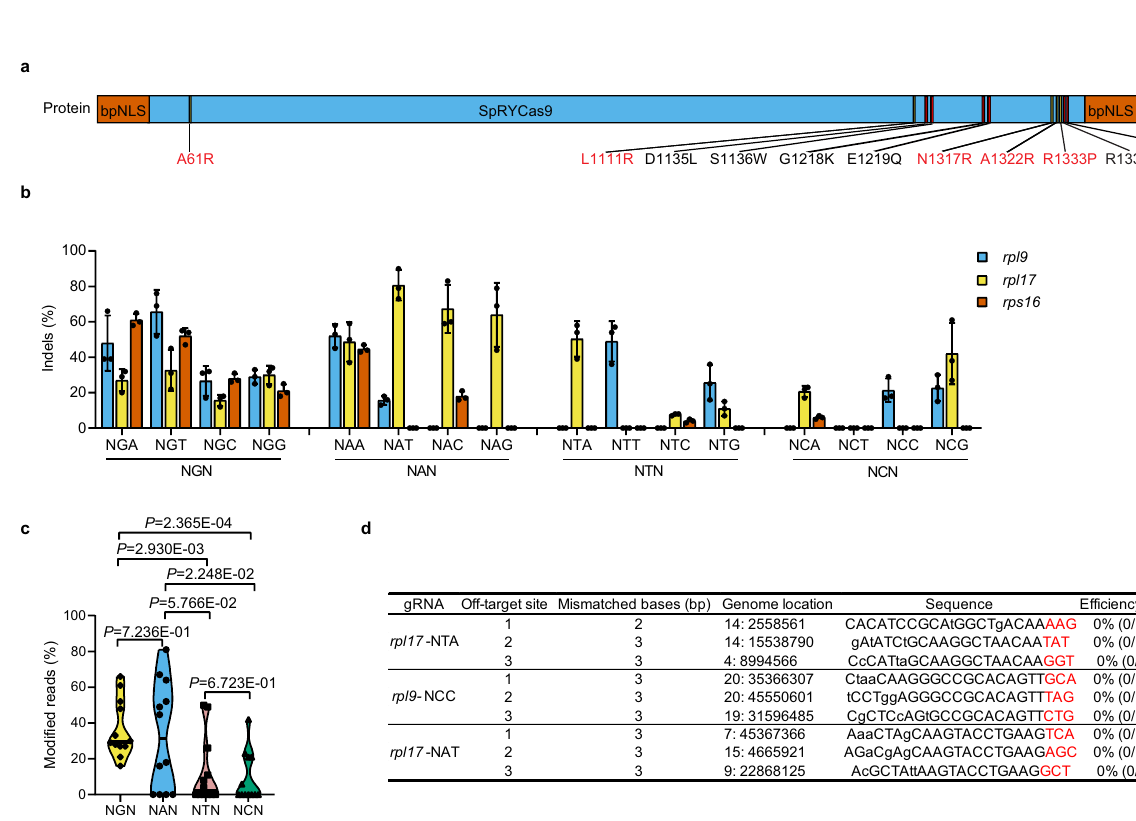
Fig. 2 Optimized SpRYCas9 nuclease targeted different NNN PAMs in zebra fi sh. a Schematic illustration of the amino acid mutations that developed SpRYCas9 from SpGCas9. Five more amino acid mutations (A61R, L1111R, N1317R, A1322R, and R1333P; in red) were introduced into SpGCas9 to obtain SpRYCas9. b The editing ef fi ciency of 48 gRNAs targeting NNN PAMs of rpl9 , rpl17 , and rps16 in zebra fi sh. (Values are presented as mean value ± standard deviation (SD), n = 3 biological replicates). c Assessment of the preference of SpRYCas9-mediated mutagenesis for the second N of NNN PAMs using the violin plot based on the data in b , Each data point represents the averaged editing activity at the particular site. The centre line shows means of all data points. Two-tailed paired t test were performed (with P values marked). d Detection of mutation at potential off-target sites induced by SpRYCas9 nuclease at three loci using NGS. The PAM sequences are underlined in red. All source data in this fi gure are provided as a Source data fi Previous studies have shown that ef fi cient germline transmis- zebra fi sh, which is consistent with the results reported in sion occurs in SpCas9-induced mutations in zebra fi sh 16 . To human cells and plants 8,12 . Considering PAM- fl exible Cas9 variants may increase the risk of off-target editing, just like we determine whether the germline transmission of SpG- and SpRY- did in SpGCas9 nuclease, we analysed the off-target effects of induced mutations was equally ef fi cient, we randomly inter- three gRNAs with relatively high cleavage activities. No off- crossed three pairs of tyr -NGT-site founders to generate F1. All target mutations were found in all the groups (Fig. 2d). six founders were con fi rmed to be heritable through the